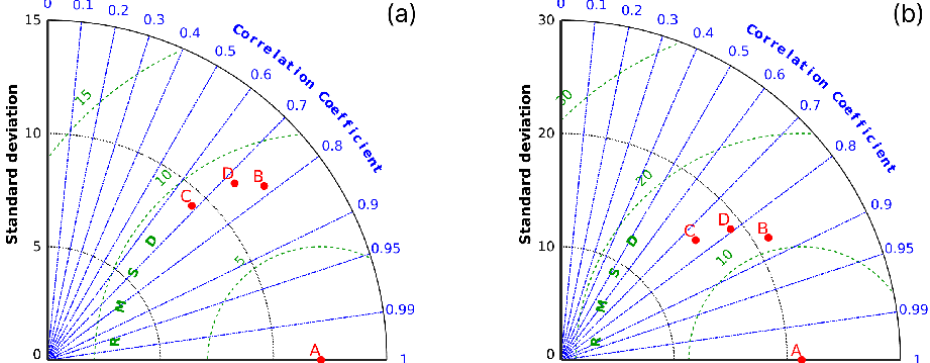
Figure 7. Taylor plots comparing H bulk flux models to EC measurements. Panel (a) has all the cases where the surface was freezing ( T 0 < 0 ◦ C), and in panel (b) are the cases where the surface was melting ( T 0 > 0 ◦ C). A denotes EC measurements, B is the constant C H model, C denotes the LHFA model and D stands for the SEA-ICE model. Green lines represent isolines of the root mean square error (RMSE), blue lines represent isolines of correlation and dashed black lines are the isolines of standard